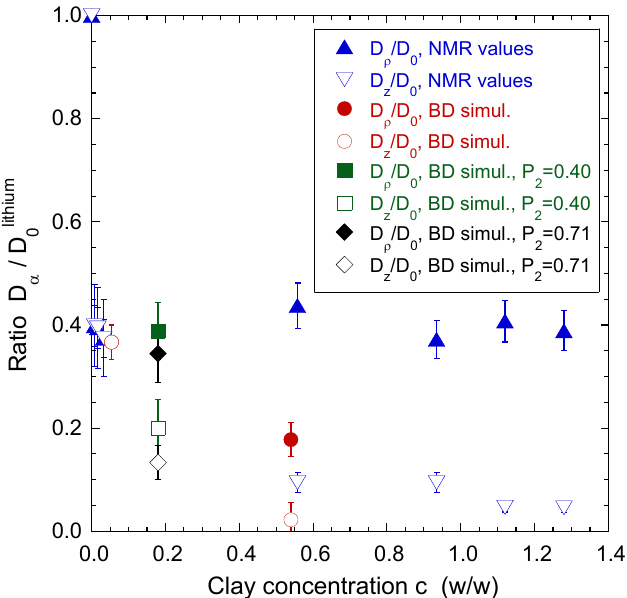
Figure 16. Influence of the clay concentration on the lithium ions self-diffusion tensor measured within laponite aqueous dispersion by using 7 Li NMR Pulsed-Gradient Spin-Echo attenuation. Reprinted with permission from Ref. [50]. Copyright (2008) American Chemical Society.